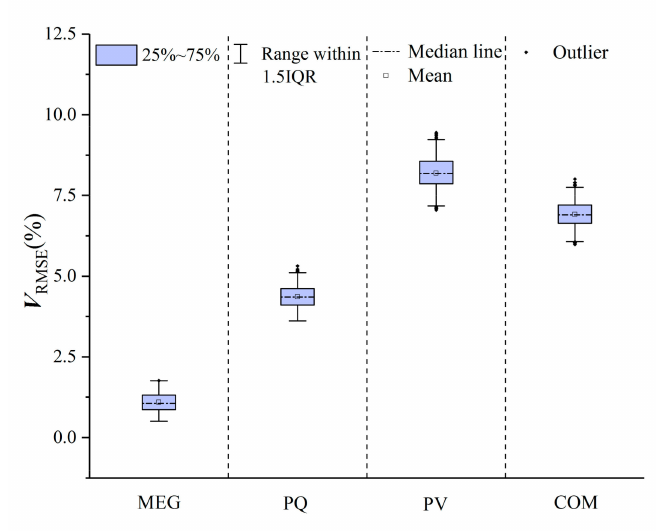
Figure 10. Mean square errors for four equivalent